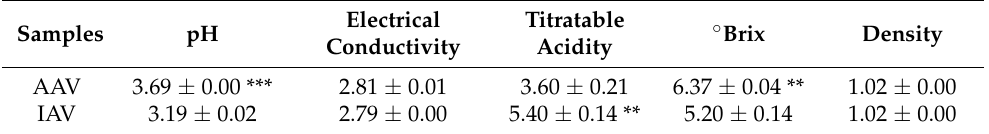
Table 1. Physicochemical parameters of vinegar samples.